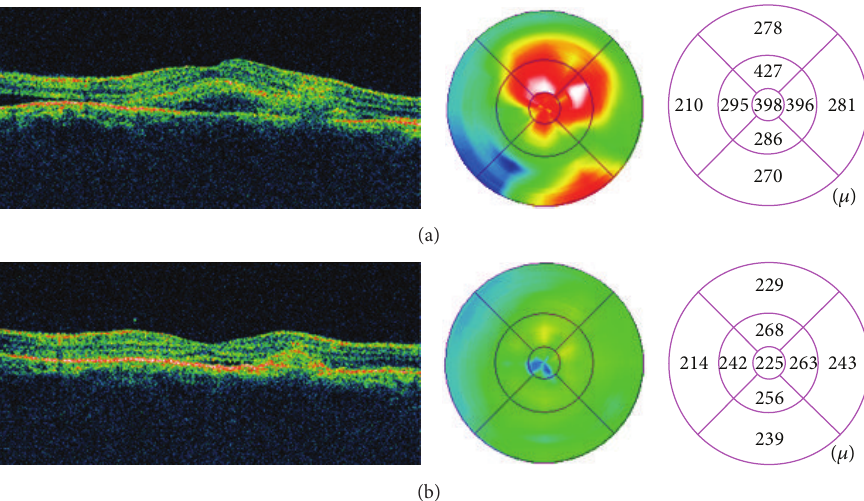
Figure 3: (a) Optical coherence tomography (OCT) revealed an increased central macular thickness (CMT) of 398 𝜇 with loss of foveal architecture and subretinal hemorrhage with a neurosensory retinal detachment. (b) Two weeks after pneumatic displacement with C3F8 and intravitreal tissue plasminogen activator, visual acuity improved to 20/80 and CMT decreased to 225 𝜇 . A hyperreflective fusiform elevation of the retinal pigment epithelium/choriocapillaris complex that seems to correspond to fibrosis tissue is seen at the thermal laser site. A small subfoveal neurosensory retinal detachment persists. However, there is normalization of the foveal